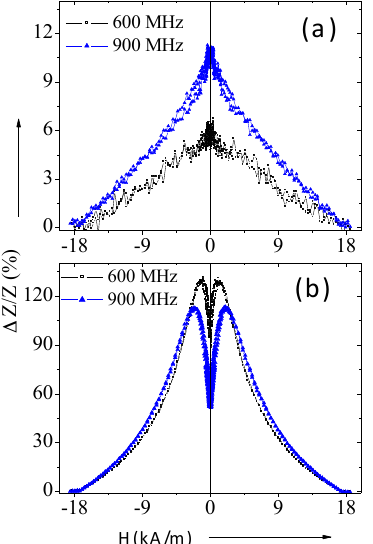
Figure 8: Δ Z/Z (H) dependences of as-prepared (a) and annealed at T = 550°C(b) ann Fe Cu Nb Si B microwires measured at 70.8 1 3.1 14.5 10.6 different